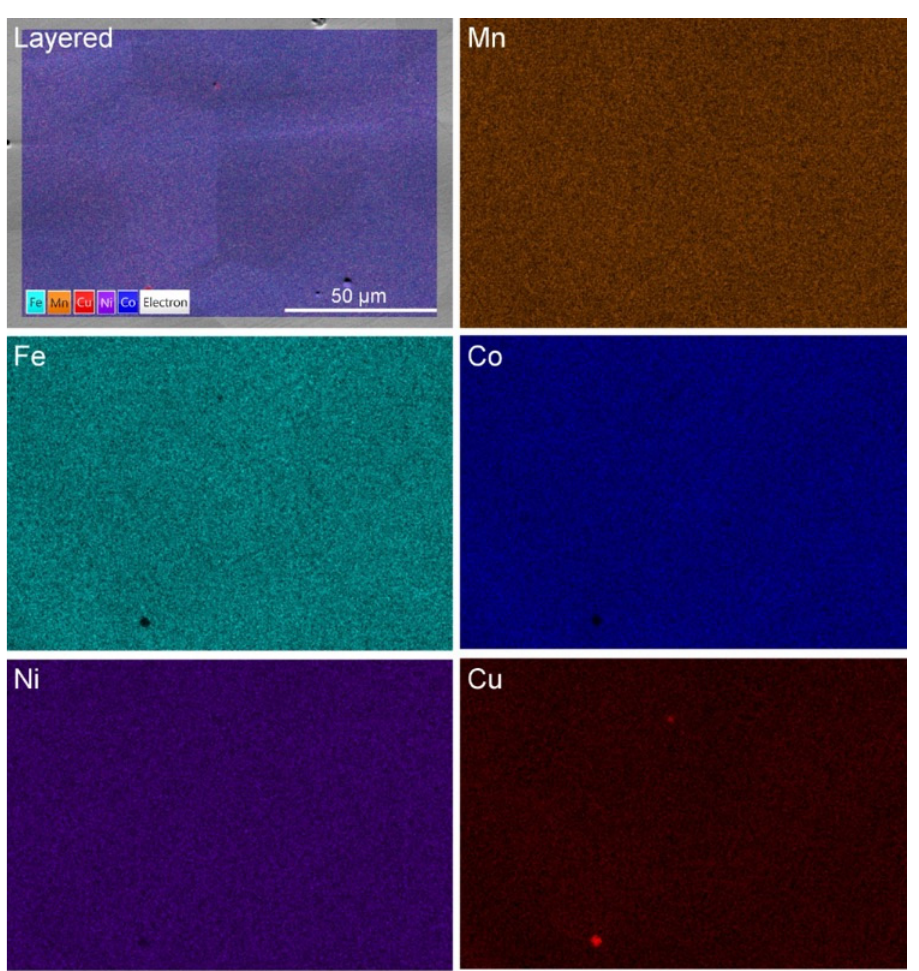
Figure 14. Layered EDS map and constituent elemental maps of homogenized